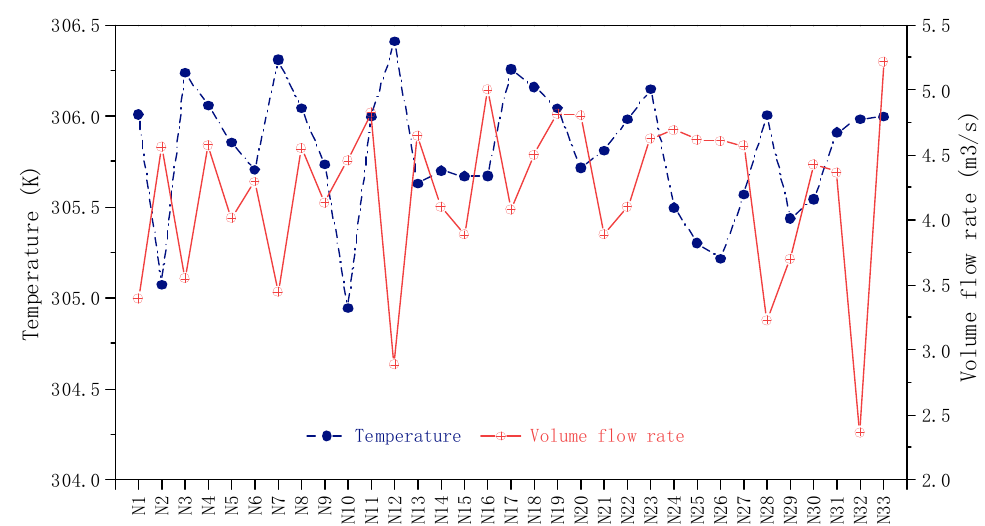
Figure 8. Volumetric flow and average temperature of a horizontal plane at a height of 1.2 m above the ground in 33 scenarios.